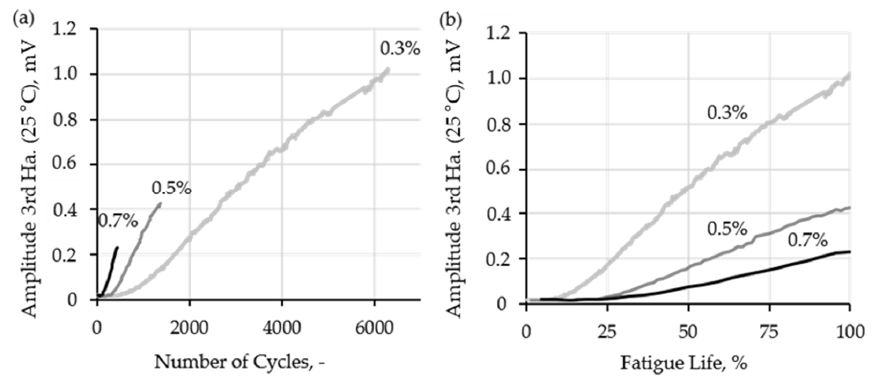
Figure 8. Evolution of the amplitude of the third harmonic at 25 °C in fatigue tests with different strain amplitudes as a function of ( a ) the number of cycles and ( b ) normalized fatigue life; recompiled from ref. [19].